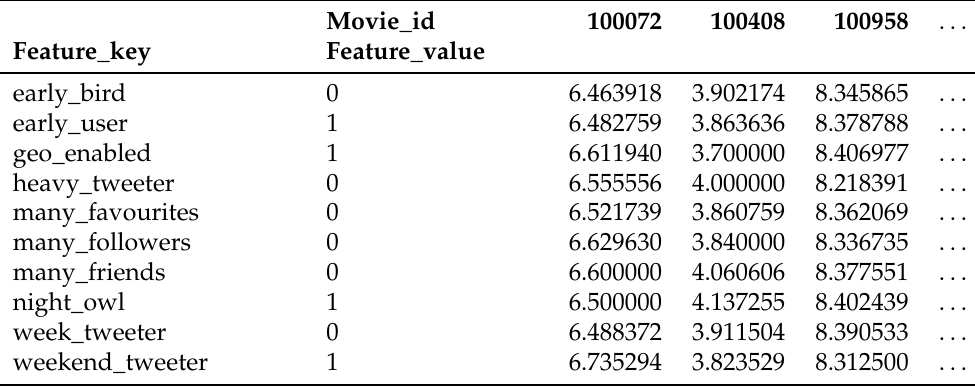
Table 3. Dataframe matrix as the result of filtering Table 1 with the features from the user selected. The resulting shape is (10, 2831), where 10 is all the user feature values from selected users, and 2831 is the number of movies.